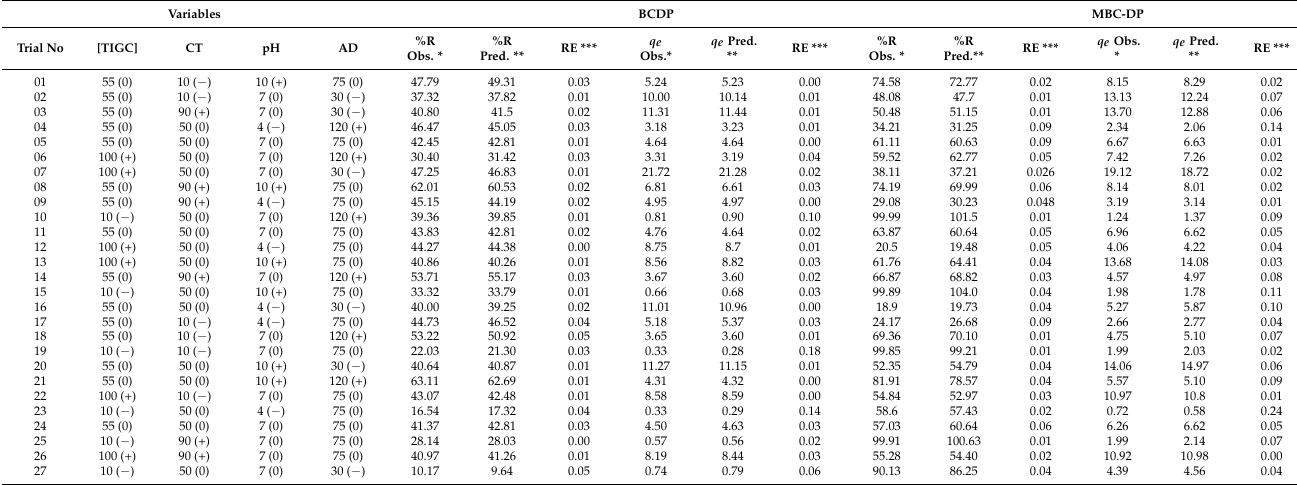
Table 2. Experimental scenario using BCDP and MBC-DP as adsorbents. Measured and predicted values of the two responses are